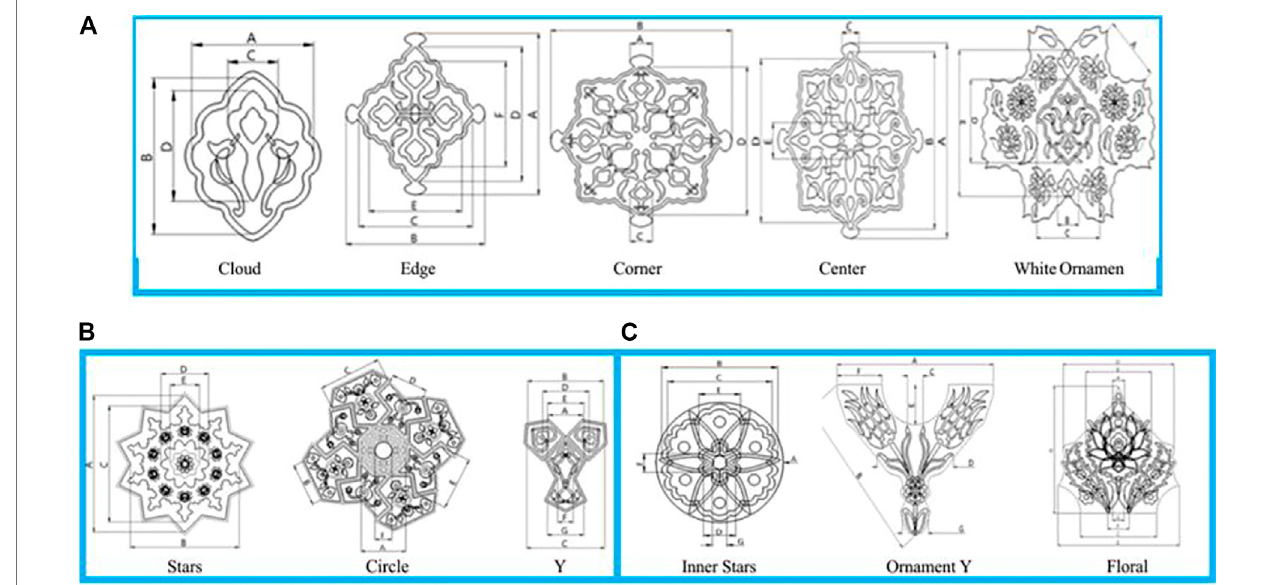
FIGURE 12 | Measurements of Islamic ceramic wall tiles: (A) Safavid tiles; (B) IGP/IBM tiles; (C) Iznik tiles.